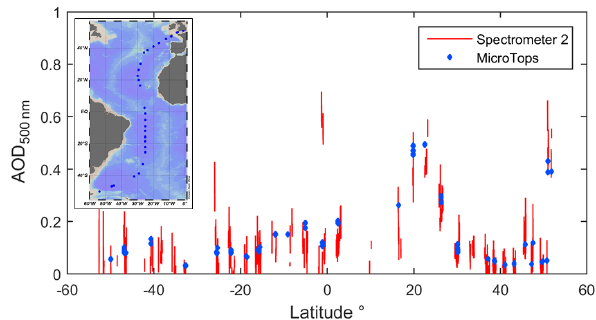
Figure 14. General evolution of AOD 500nm as measured by Spec- trometer 2 (Zeiss, red line) and Microtops (blue diamonds) over the duration of the AMT24 cruise. Map of the Microtops sampling lo- cations shown in the upper left of figure.